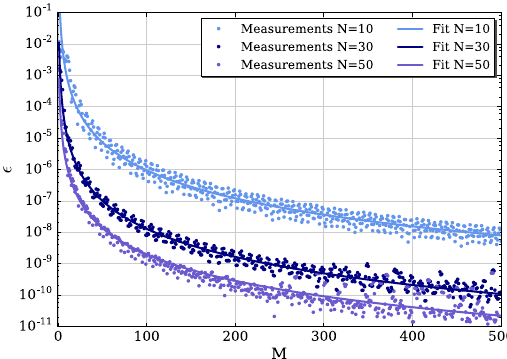
FIG. 5. Convergence of the mixed BPM method in the numerical simulations, for three cases of turns, with respect to the number of turns. After introducing the varying frequency scheme, the resonances disappear.